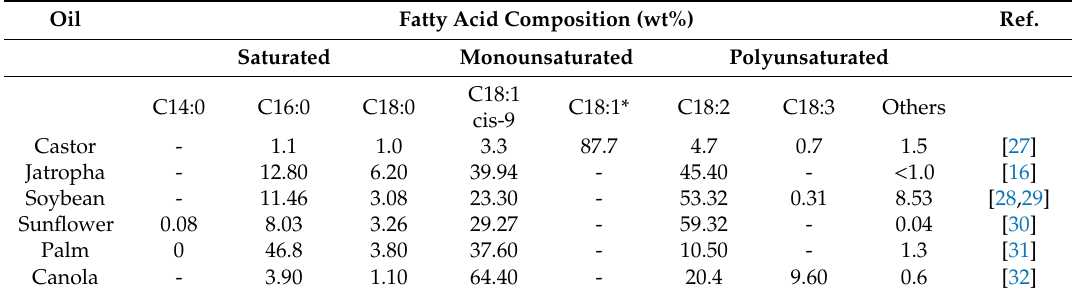
Table 2. Main fatty acids in vegetable oils used as feedstock in biodiesel